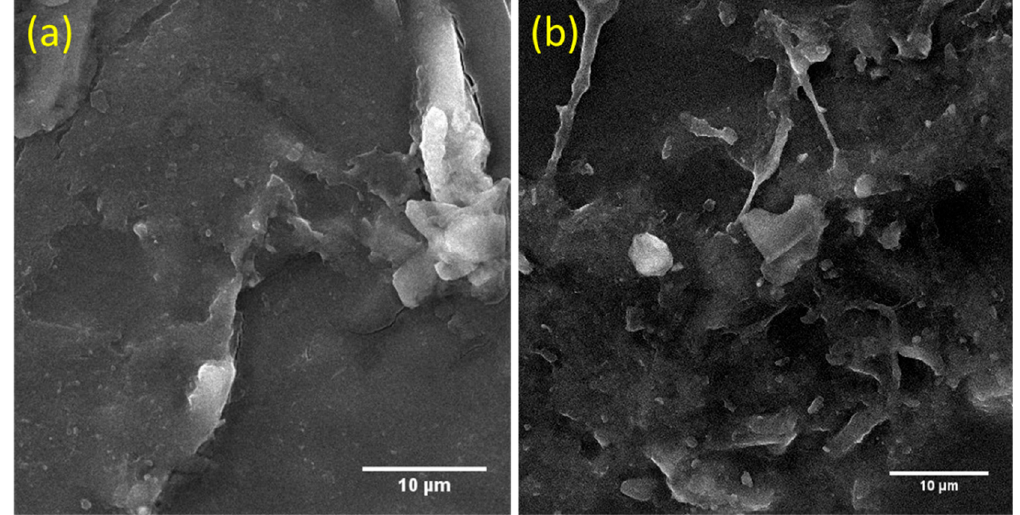
Figure 3. SEM images of the GNF (5%) with Potato starch ( a ) and Tapioca starch ( b ).